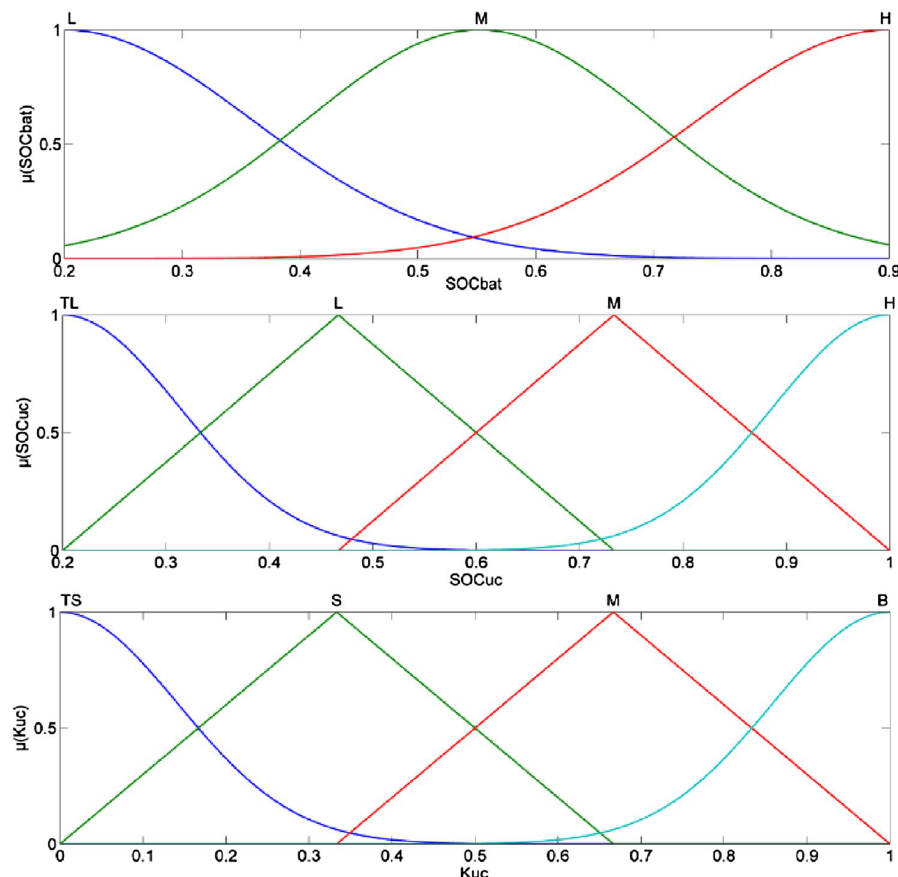
Fig. 6 Input and output mem- bership function of charging fuzzy